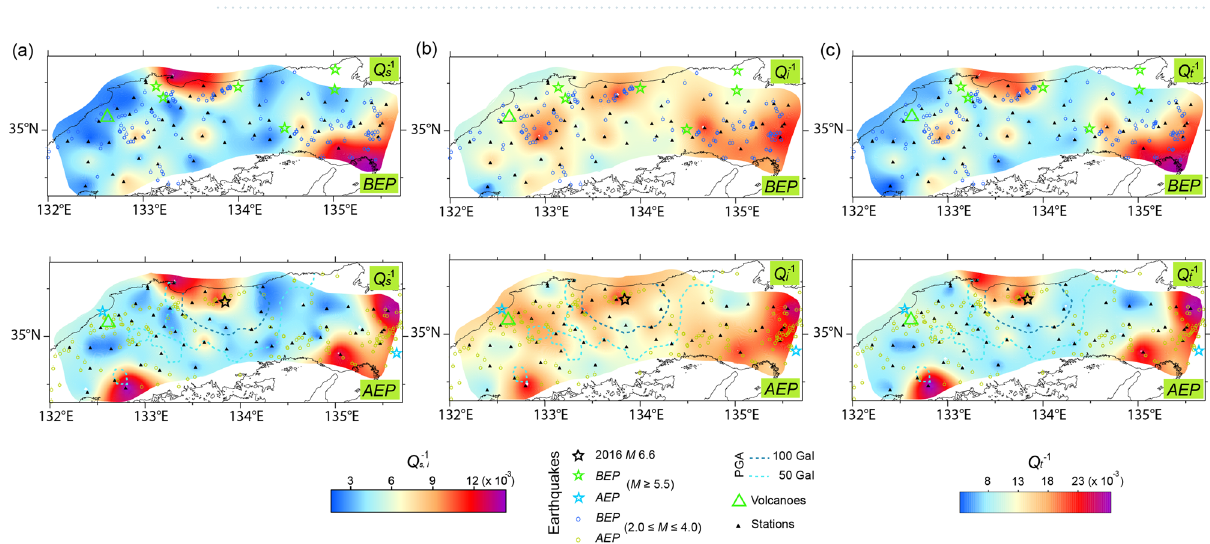
Figure 3. Map of the ( a ) Q s –1 , ( b ) Q i –1 , and ( c ) Q t –1 value at 1.5 Hz in the BEP (top) and AEP (bottom) for the Tottori earthquake ( M 6.2). The styles and symbols are the same as those in Fig.